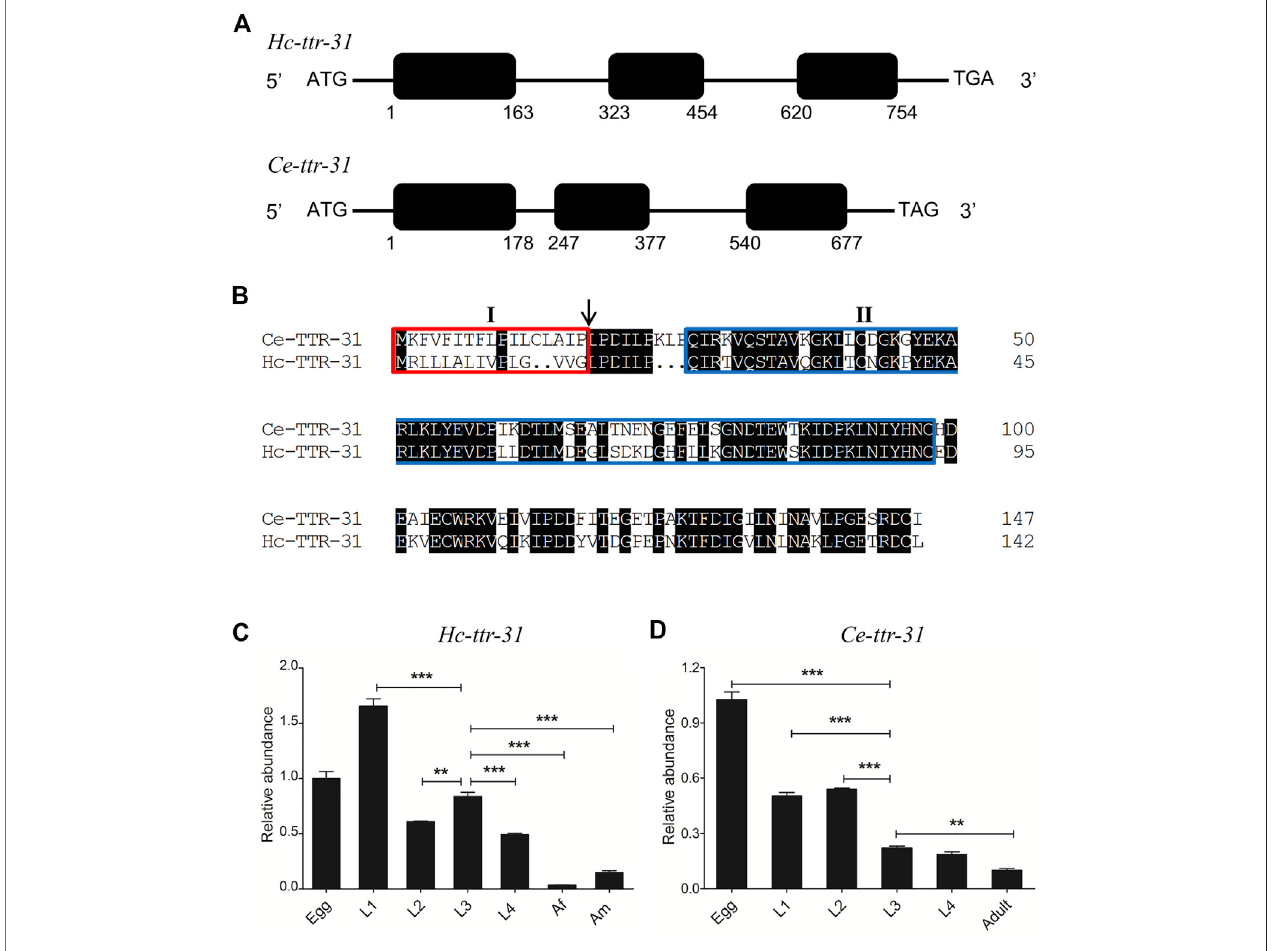
FIGURE1 | Sequence and transcription analyses of ttr-31 in Haemonchus contortus and Caenorhabditis elegans . (A) Gene structuresof Hc-ttr-31 and Ce-ttr-31 . Black boxes and the horizontal lines represent exons and introns, respectively. The numbers below the black boxes indicates the boundaries of exons. (B) Pair-wise sequence alignment of the predicted TTR-31 of C. elegans and H. contortus . Identical residues are shaded in black. The red box (I) indicates the predicted secretory signal,thearrowpointstheputativecleavagesitesandthebluebox(II)showsthetransthyretindomain.Transcriptionalpatternsof Hc-ttr-31 (C) and Ce-ttr-31 (D) in different developmental stages of H. contortus and C. elegans . Egg, fi rst (L1), second (L2), third (L3), fourth (L4) larval, female adult (Af) and male adult (Am) stages are indicated. * p < 0.05; ** p < 0.01; *** p < 0.001.